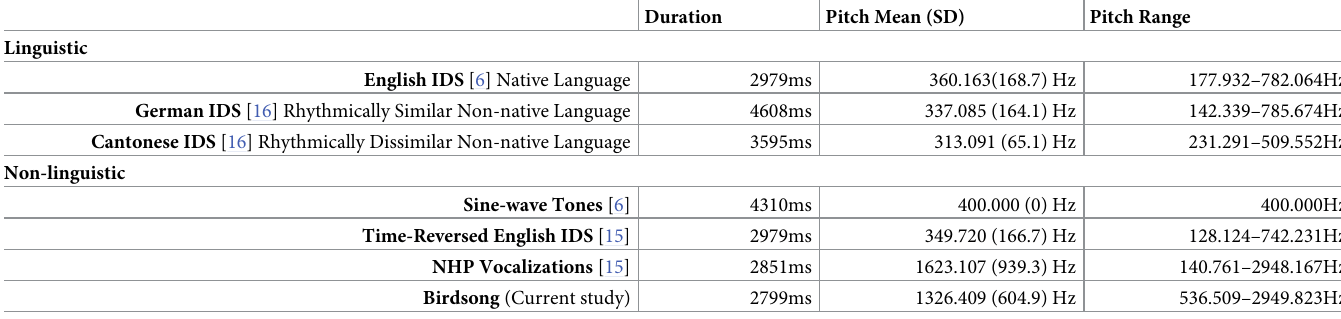
Table 1. Duration and pitch of acoustic stimuli from previous studies and current